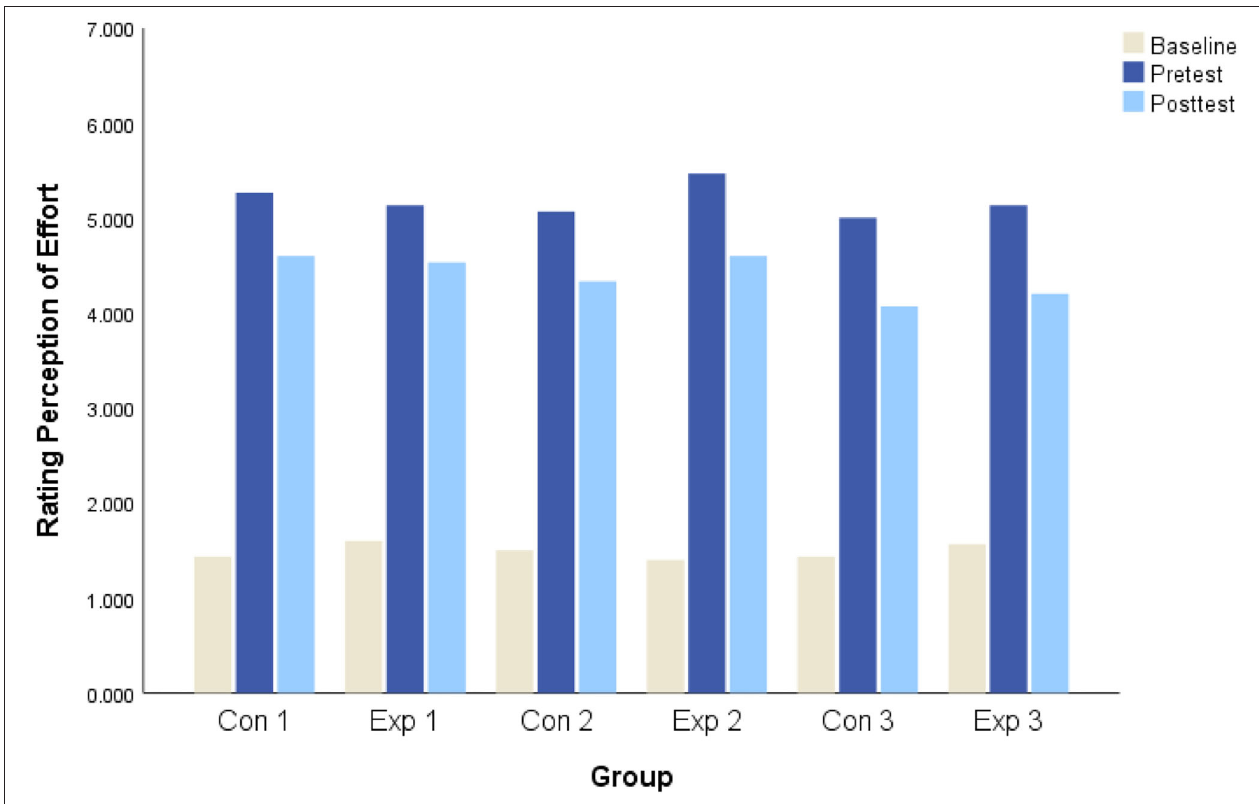
FIGURE 2 | The changes in rating perception of effort in each